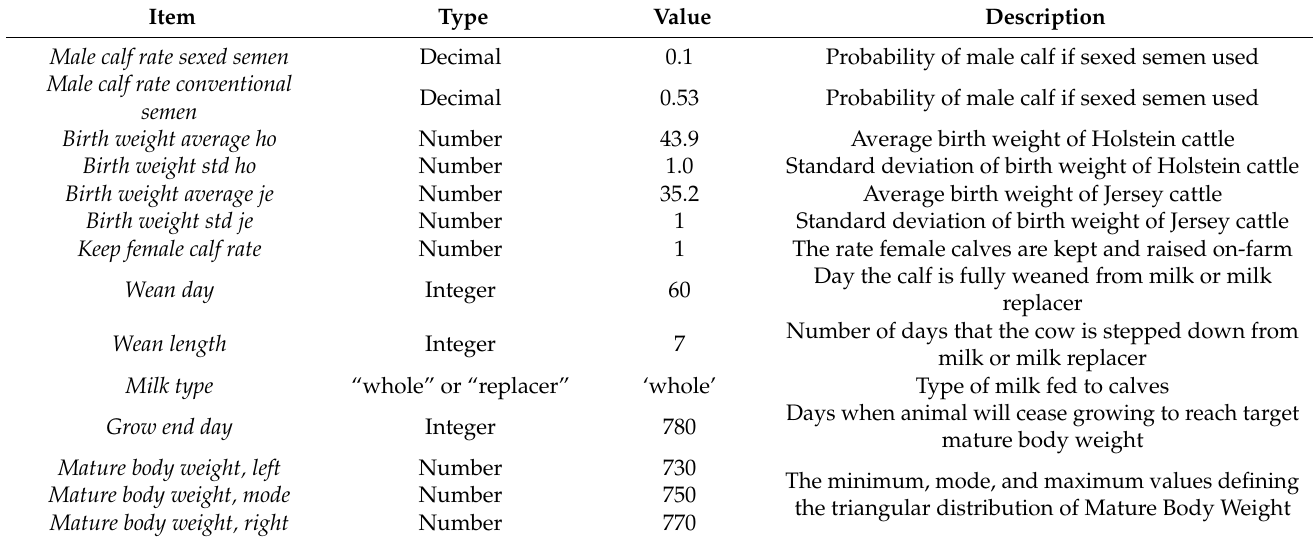
Table A2. User inputs in the Ruminant Farm Systems Model related to animal level management.